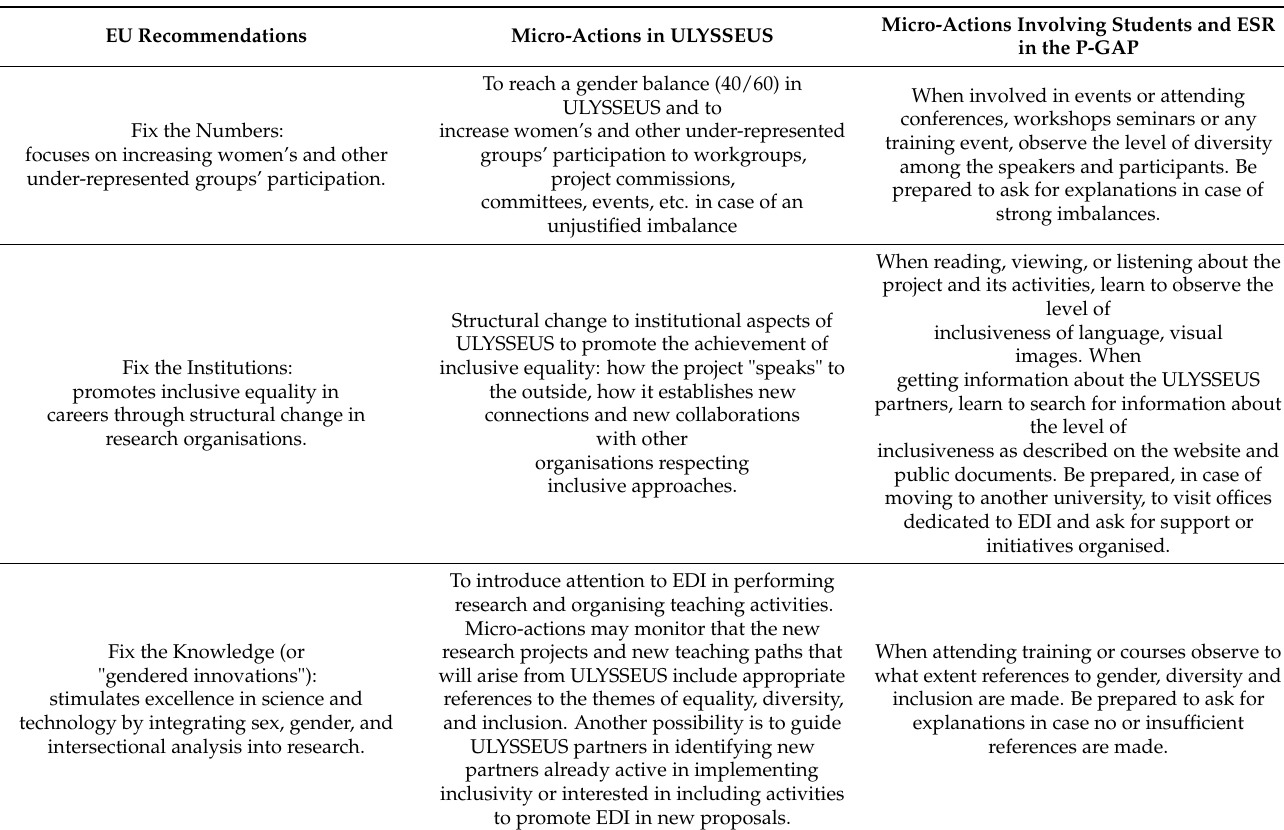
Table 2. The three major strategic approaches to gender equality in science research, policy, and